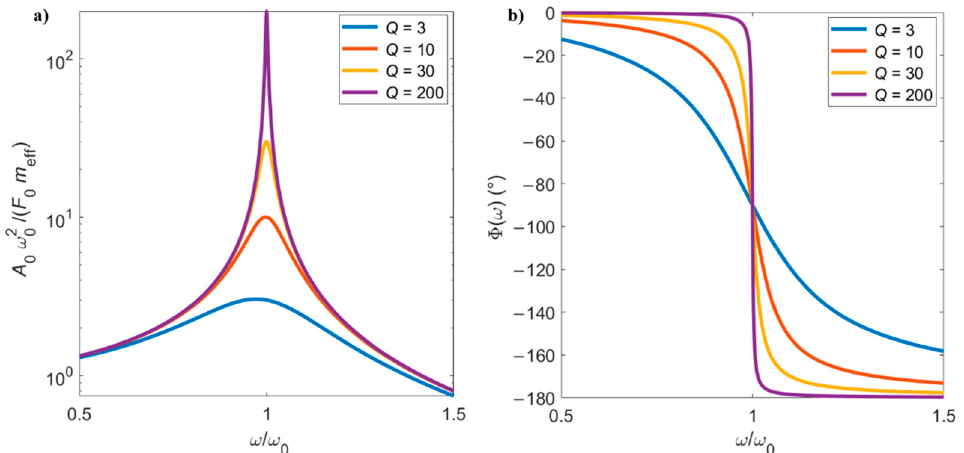
Figure 3. ( a ) Amplitude and ( b ) phase responses as function of the normalized excitation frequency of a forced and damped harmonic oscillator. Four different levels of damping ( Q ) are considered, typically encountered in microcantilevers vibrating in air or liquid mediums.